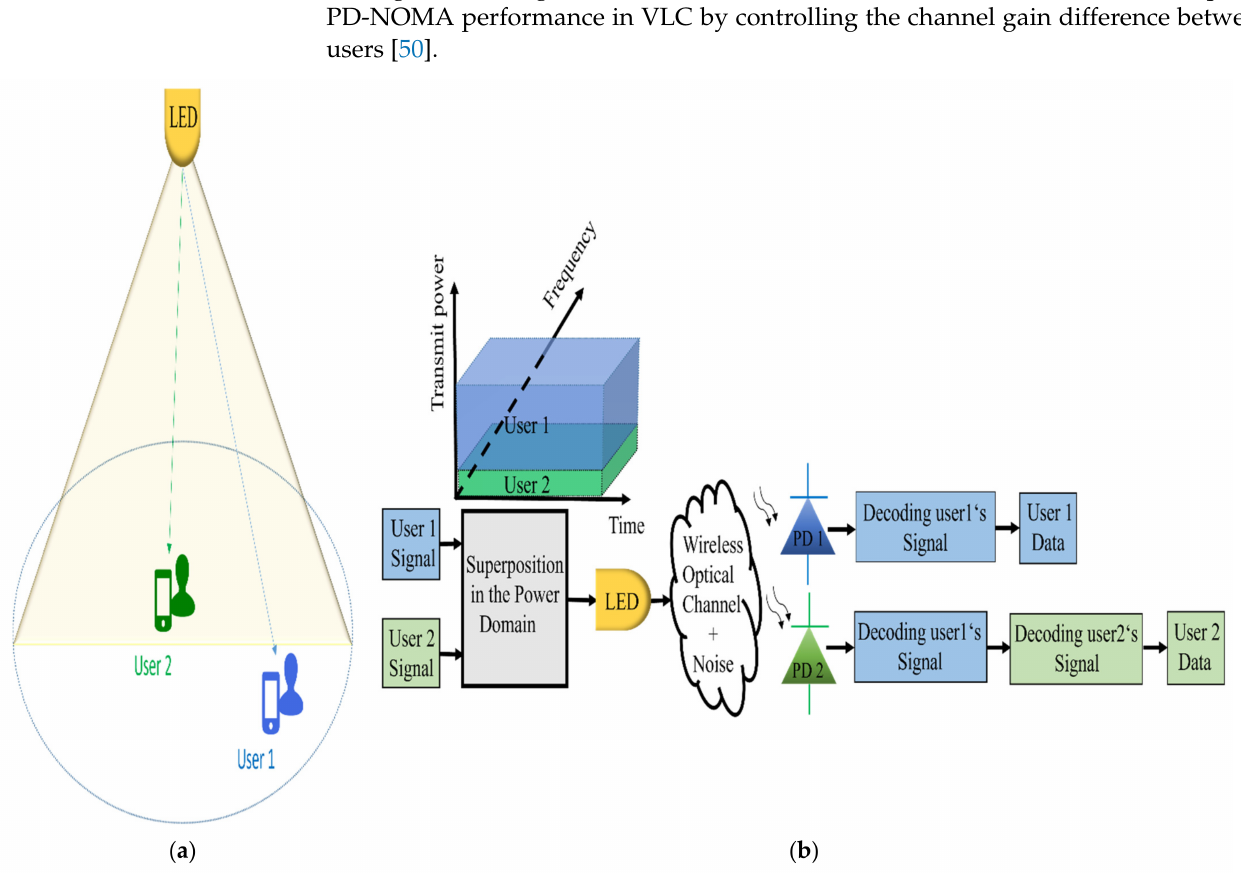
Figure 9. An illustration of a two-user downlink PD-NOMA scheme in the VLC: ( a ) system model; ( b ) SC and